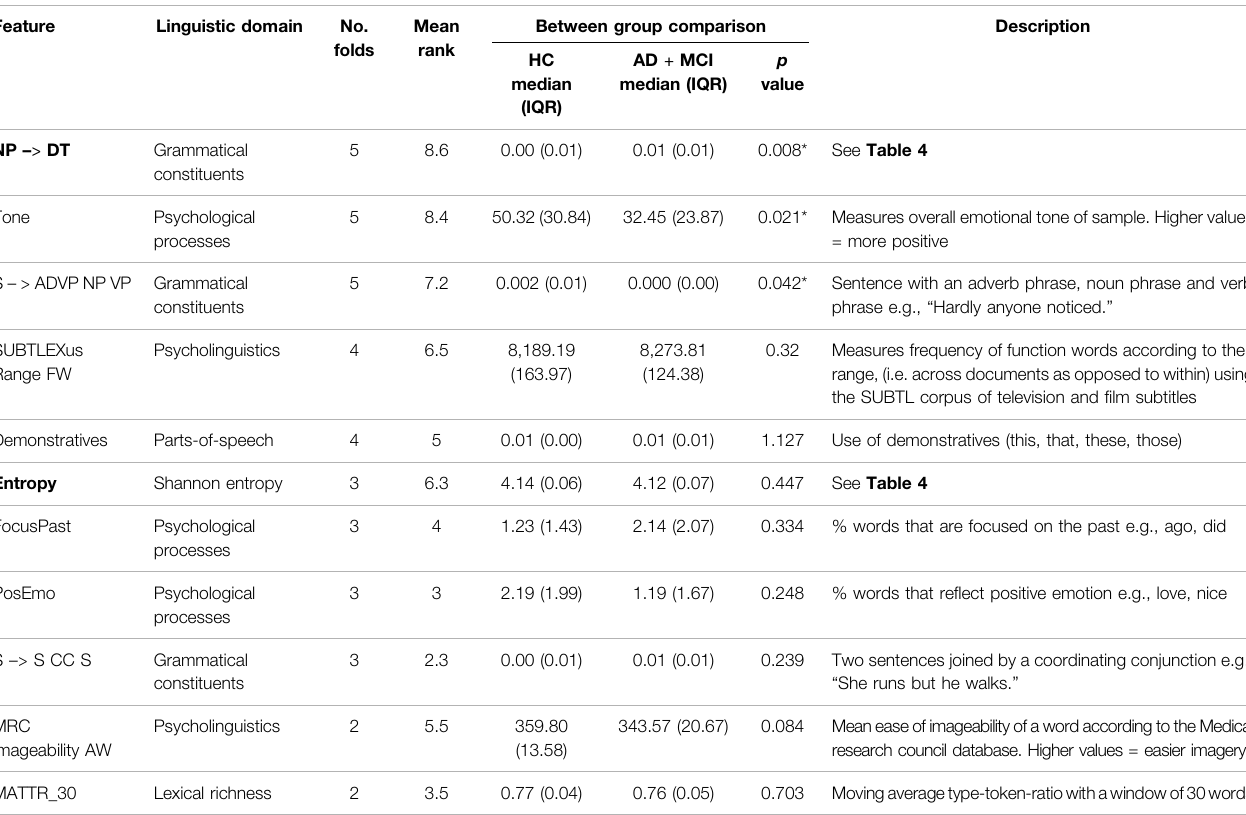
TABLE 5 | Important features of picture description for classifying of HC vs. AD + MCI. Mann Whitney U tests Bonferroni adjusted for multiple comparisons and reported in corrected form.